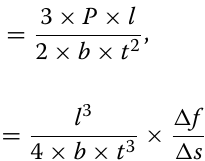
Fig. 5 Density of different layups. Note group A consists of poplar veneer and bamboo mat as surface layer. Group B consists of two bamboo mats as surface layer. Group C consists of two poplar veneers as surface layer